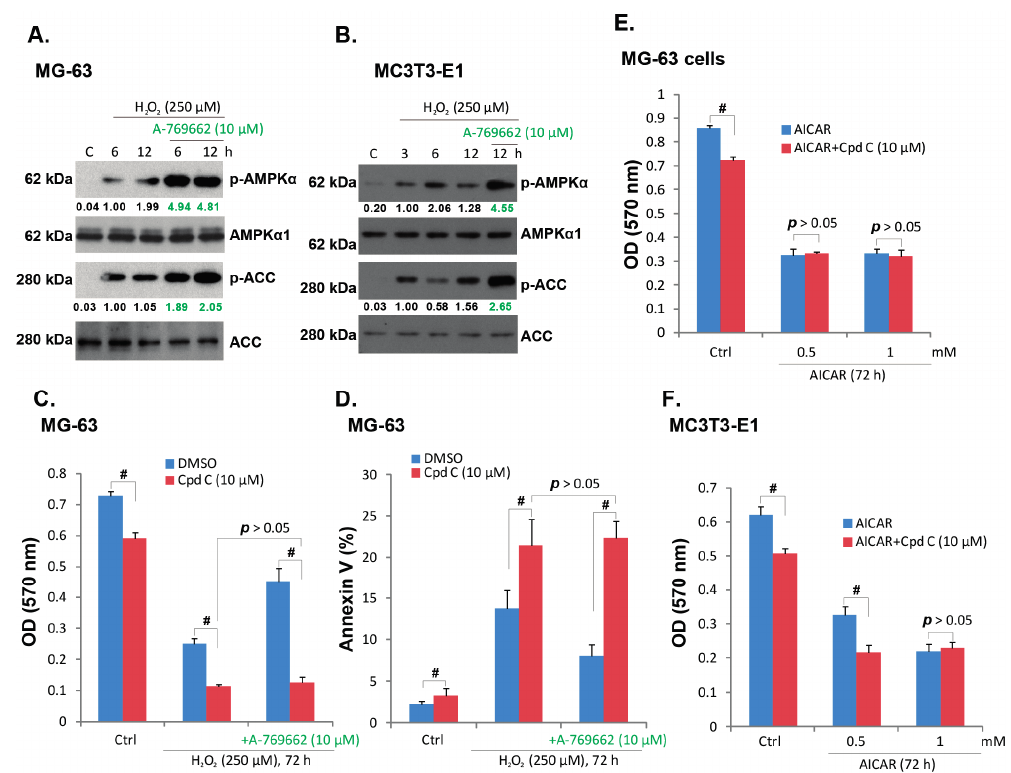
To further confirm that AMPK activation is required for A-769662-induced pro-survival effect,